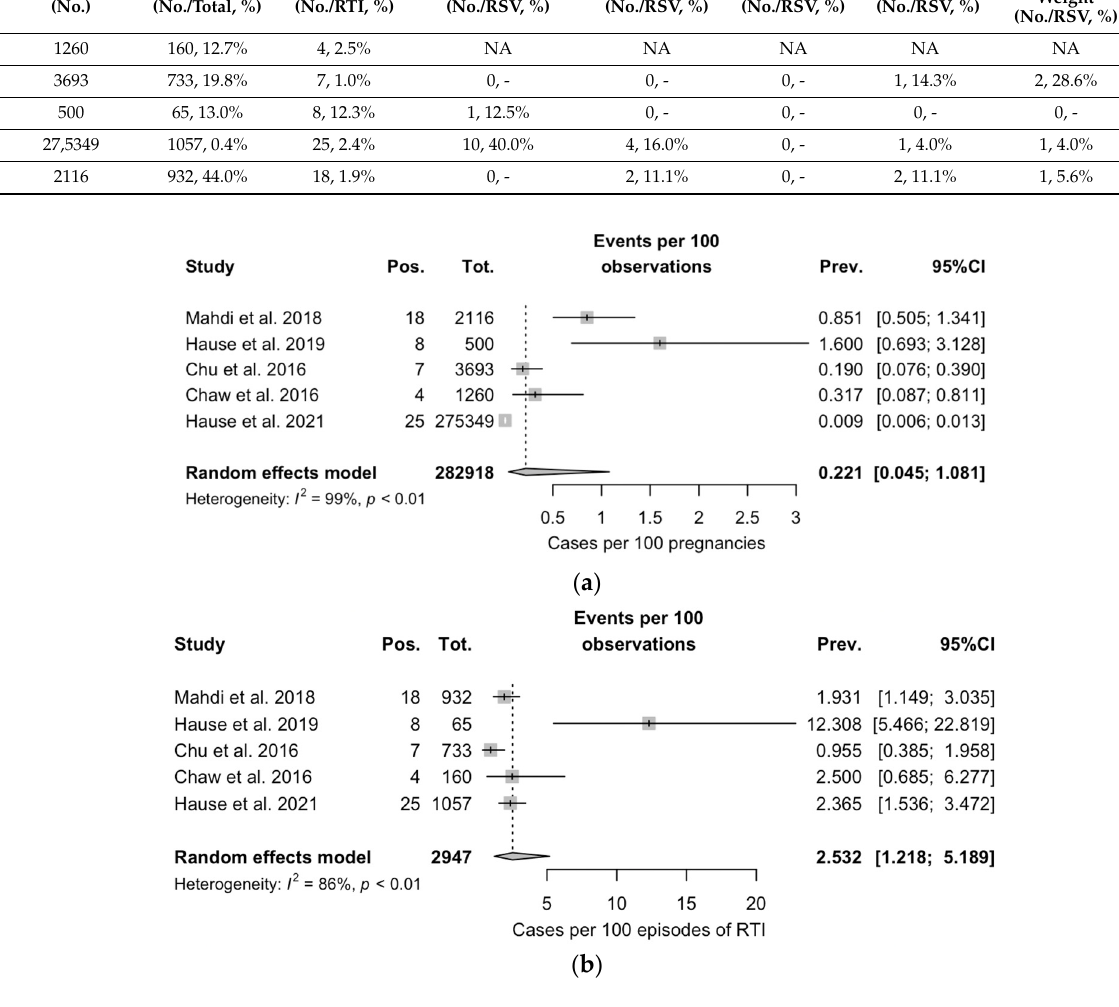
Figure 3. Incidence of RSV infections ( a ) among sampled pregnancies and ( b ) among cases of respiratory tract infections (RTI) in sampled pregnancies. A pooled incidence of 0.221 cases per 100 pregnancies (95%CI 0.045 to 1.081) and 2.532 per 100 RTI episodes (95%CI 1.218 to 5.189) was identified. In both cases, estimates were affected by substantial heterogeneity (I 2 = 99% and I 2 = 86%, respectively) .